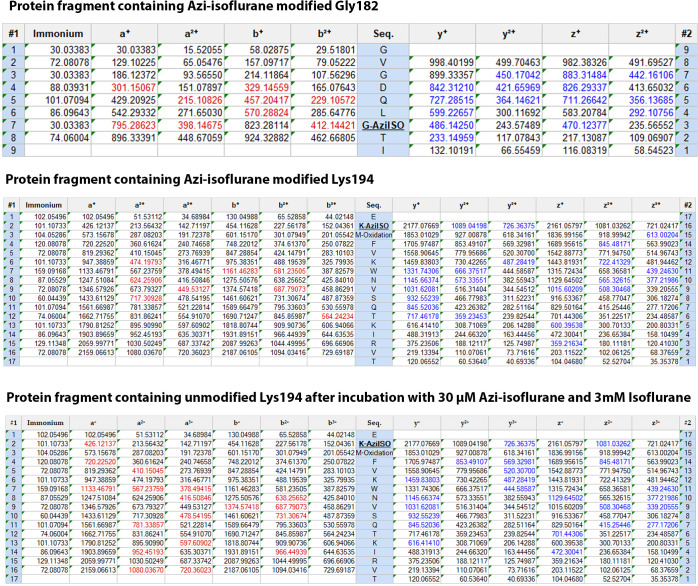
Mass spectrometry protein fragment tables.Shown are the fragmentation tables of the (top) 176-GVGDQLGTI-184 photolabeled peptide in the presence of 30 μM azi-isoflurane (middle) the 193-EKMFVKWNVSQTKIRVT-209 photolabeled peptide in the presence of 30 μM azi-isoflurane, and (bottom) the 193-EKMFVKWNVSQTKIRVT-209 photolabeled peptide in the presence of 30 μM azi-isoflurane (AziISO) and 3 mM isoflurane. Detected identified a, b (red) and z, y (blue) ions are colored red and blue, respectively. Residues detected with a modification are noted, and those modified by azi-isoflurane are additionally noted in bold and underlined.